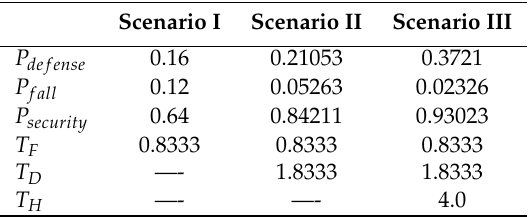
Table 11. Analysis results of probability and